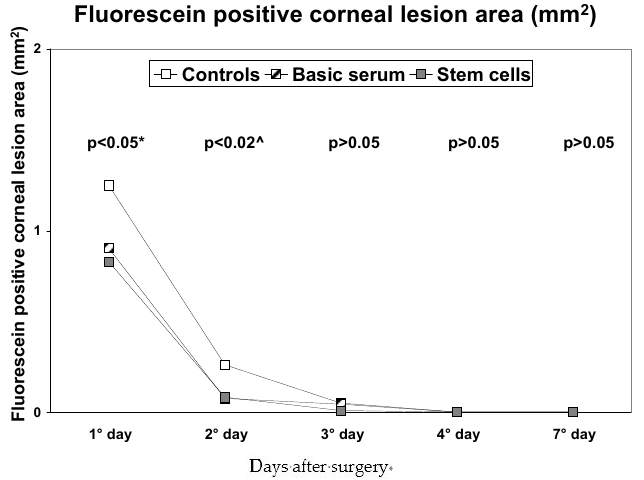
the other groups; c = significantly higher than the other groups.